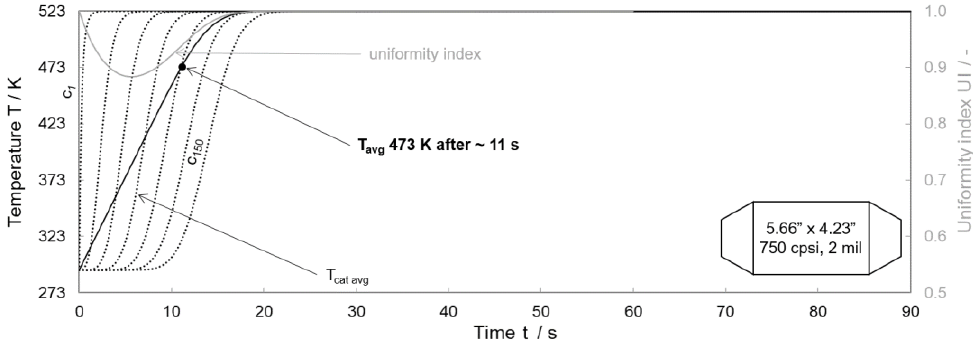
Figure A4. Heat-up of 600 cpsi, 2 mil with reduced length at steady state heat-up.